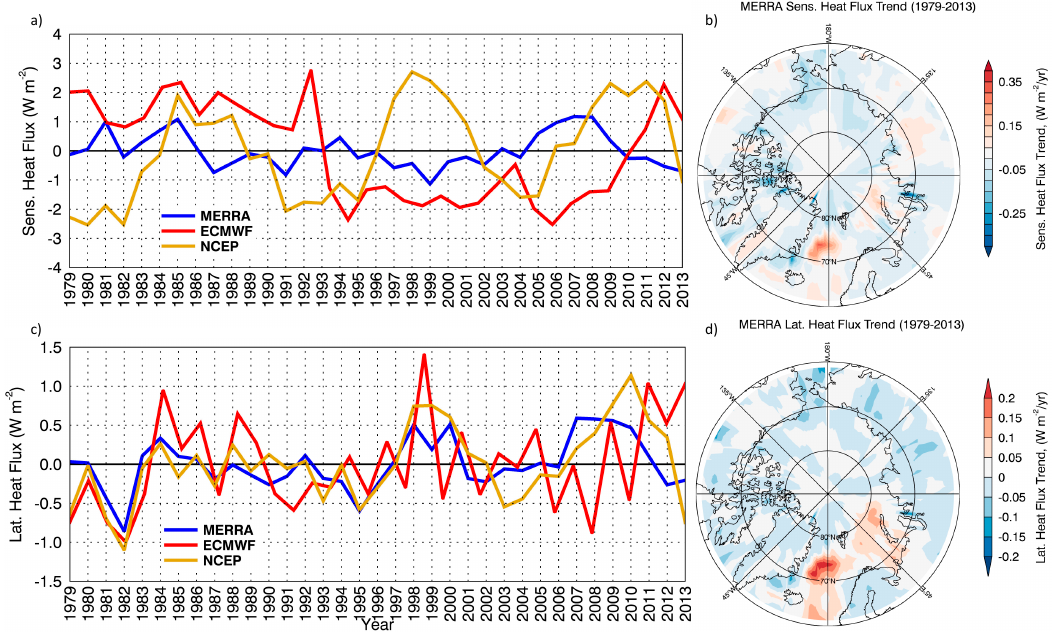
Figure 10. Panel ( a ) shows the SH flux time series for three reanalysis data sets (see legend) between 1979 and 2013 averaged over the entire Arctic (land and ocean) poleward of 60° N. Panel ( c ) as in ( a ) except showing LH flux. The spatial distribution of the annual-average ( b ) SH and ( d ) LH trends from 1979–2013 for NASA’s Modern Era Reanalysis (MERRA) are shown.